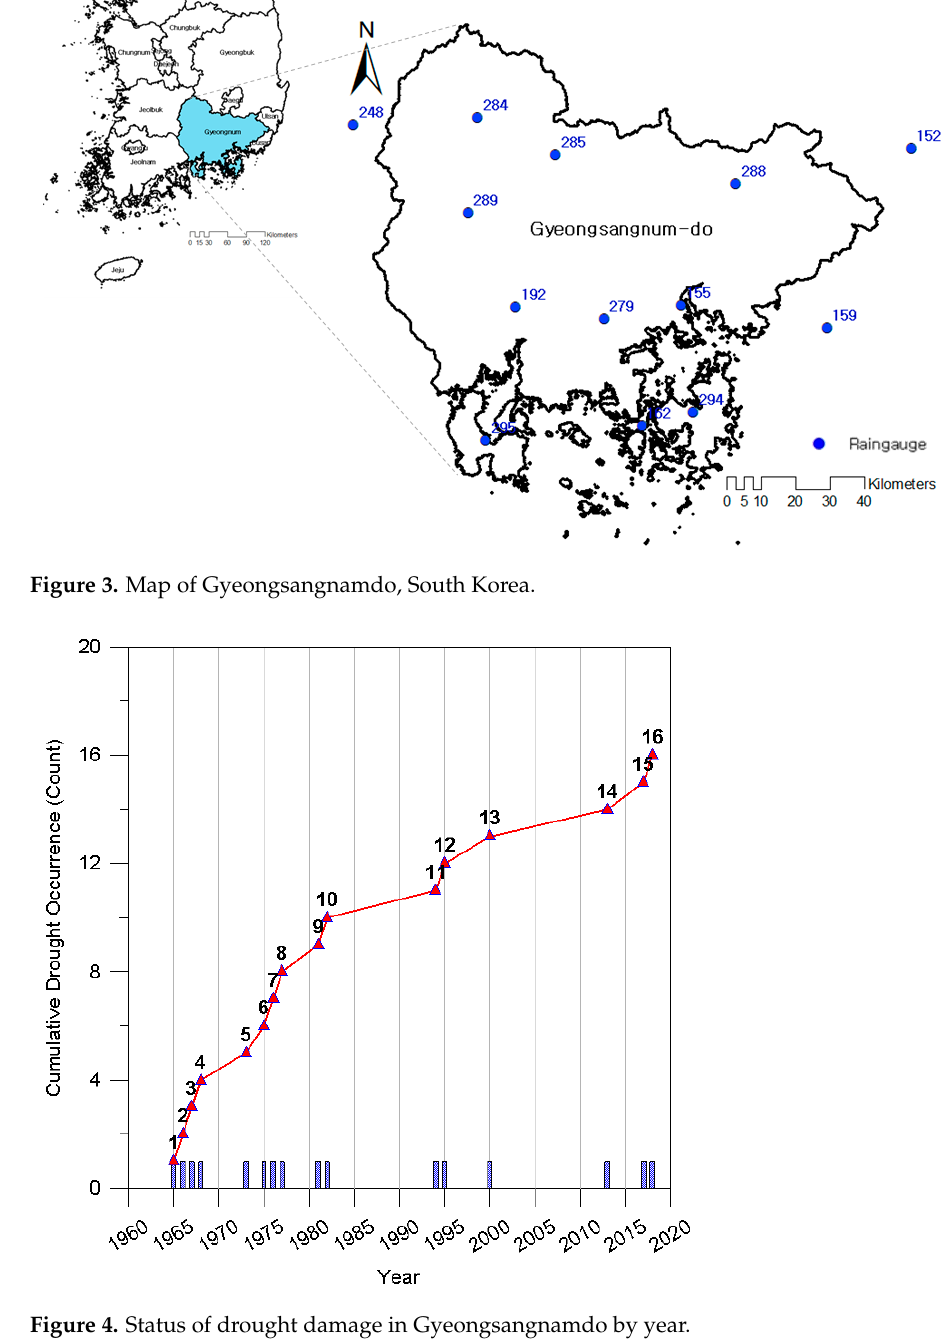
Figure 3. Map of Gyeongsangnamdo, South Korea.